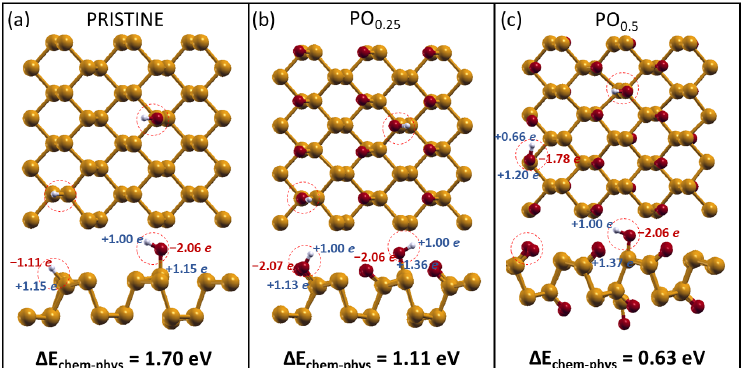
Figure 4. Water dissociation on the three phosphorene substrates: ( a ) pristine phosphorene and oxidized phosphorene with an oxygen coverage of, respectively, ( b ) 25% and ( c ) 50%. Above, the top view is shown, while below, the lateral views are reported. The partial charges transferred among atoms are reported alongside the three adsorption energies.